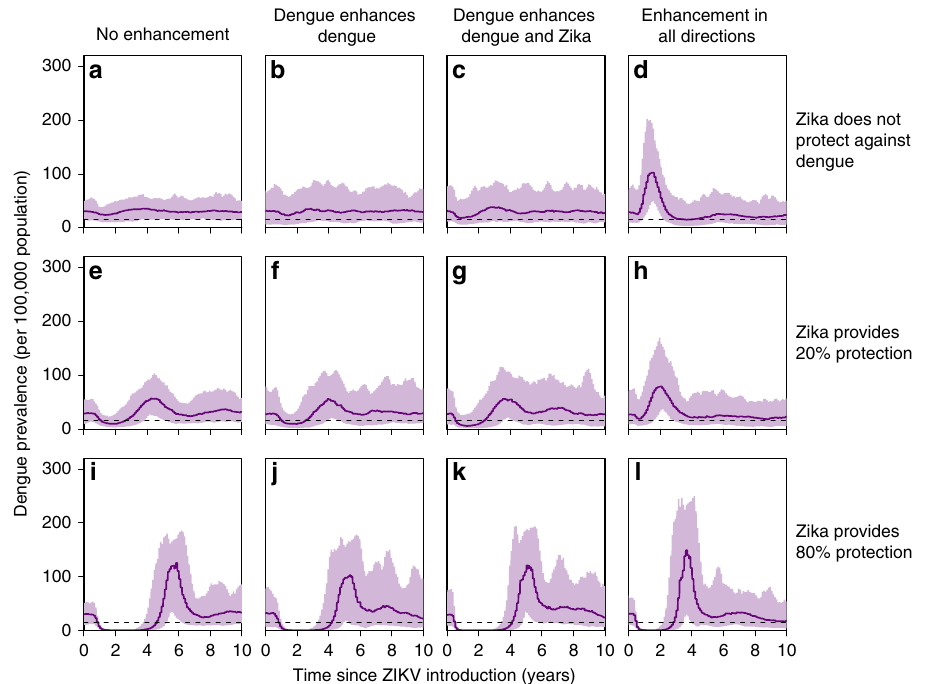
Fig. 4 Simulation results incorporating immune-mediated interactions between DENV and ZIKV. Mean and 95% inter-quantile range from stochastic simulations spanning 10 years post ZIKV-introduction. 100 simulations per scenario (see “ Methods ” for further details). ZIKV introduced after a 100 year burn-in period for four DENV serotypes (see Supplementary Fig. 11 for results when ZIKV is introduced 40 years after DENV). DENV and ZIKV reproduction numbers are assumed to be 4 and 2, respectively. Other reproduction number combinations are considered in Supplementary Fig. 10). The dashed line indicates one-half of the average incidence in ( a ) which we use to de fi ne the start and end of DENV prevalence troughs (see Methods